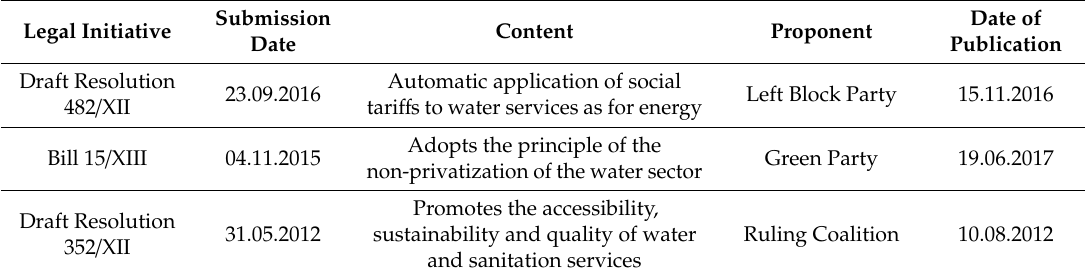
Table 4. Legal initiatives approved with an explicit reference to the HRtW.